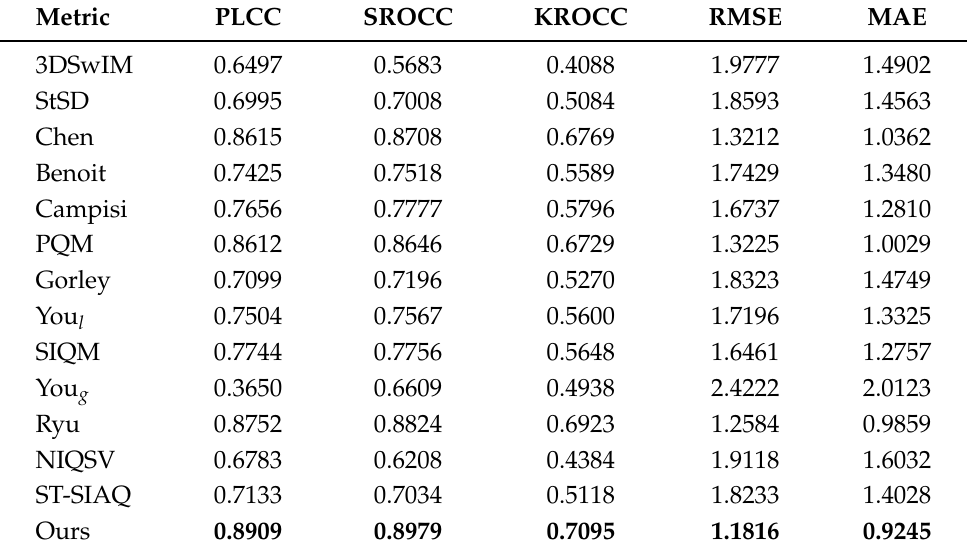
Table 2. Overall performance comparison of the proposed and the compared 3D image quality assessment metrics on MCL-3D dataset. The best results are highlighted in